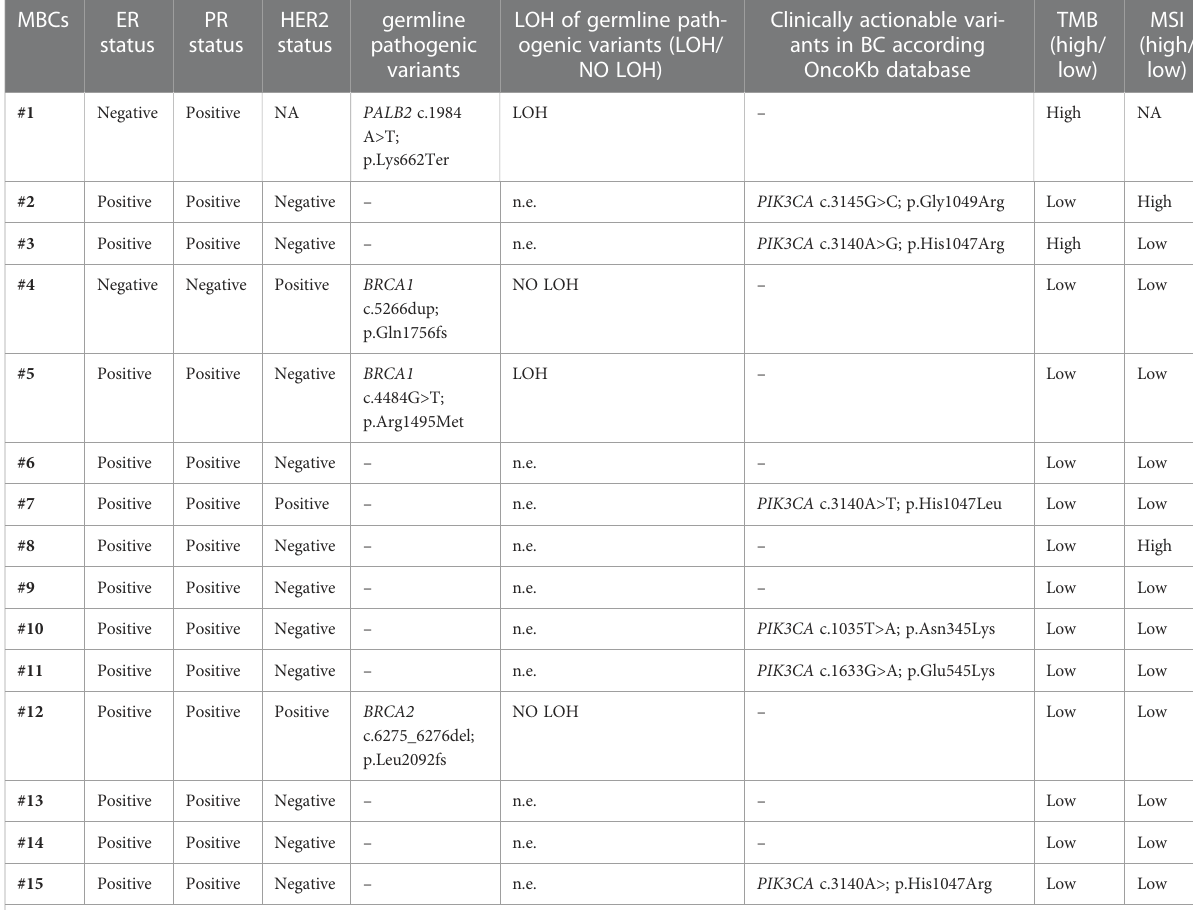
TABLE 2 Actionable molecular alterations identi fi ed in the 15 MBCs analyzed in this study.